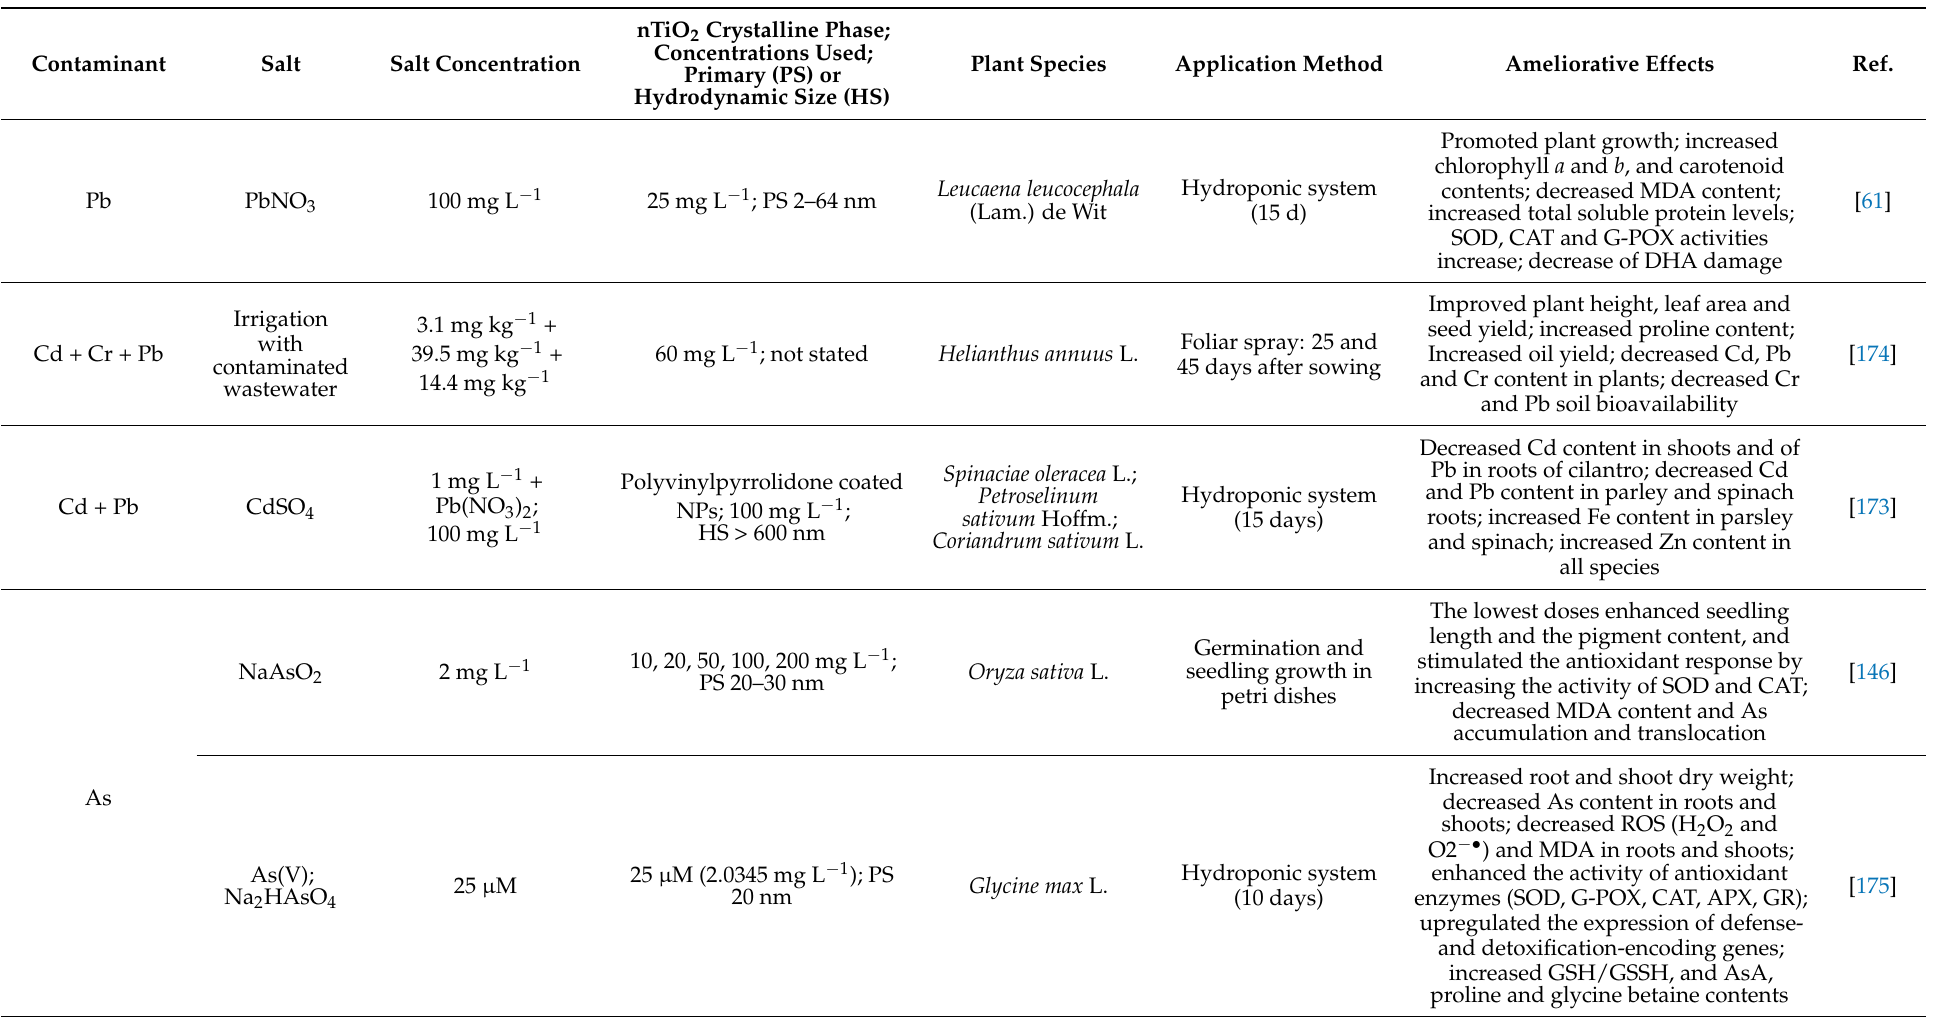
Table 8. Ameliorative effects of nZnO application against the phytotoxicity of environmental contaminants.